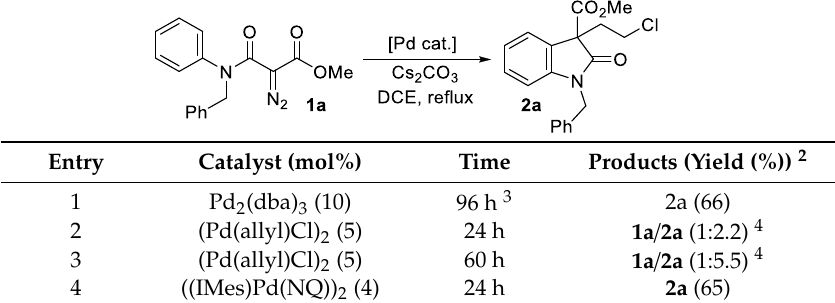
Table 1. Palladium-catalyzed reactions of α -diazoamide 1a 1 .